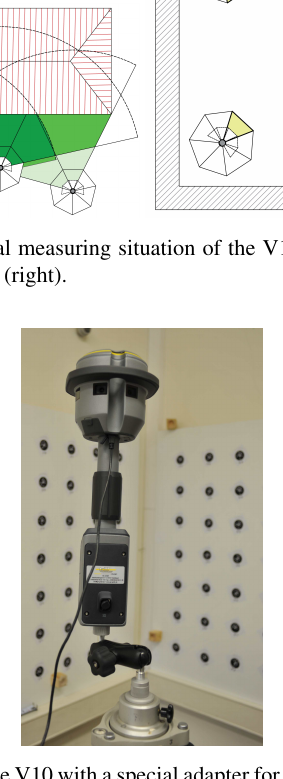
Figure 2: Trimble V10 with a special adapter for tripods. Usually, in day-to-day applications the Trimble V10 is used with a plumb rod and a shock-absorbing tip.